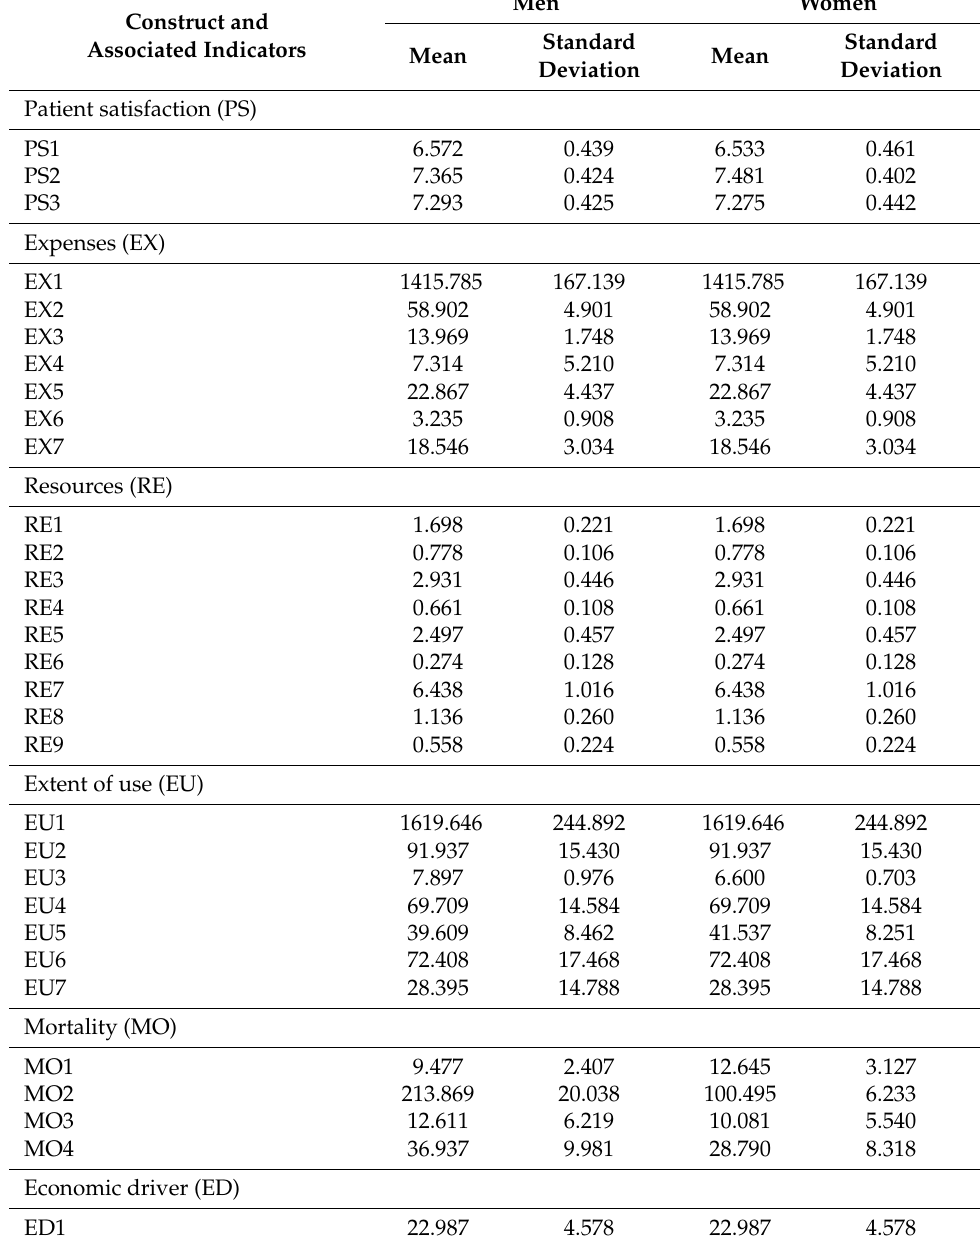
Table 2. Descriptive